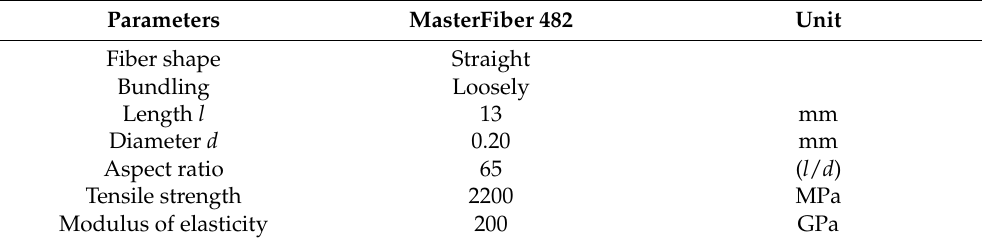
Figure 3. MasterFiber 482 fibers ( a ), dosing of the fibers in a mixer ( b ), and a concrete mix with fibers ( c ). Table 1. Parameters of MasterFiber 482 fibers.